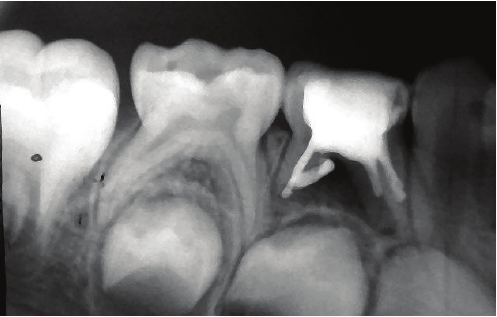
Figure 4: Obturation of the